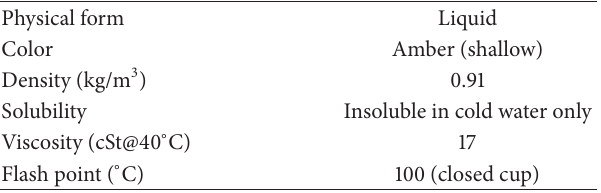
Table 2: Physical and chemical properties of H4140 lubricity agent.